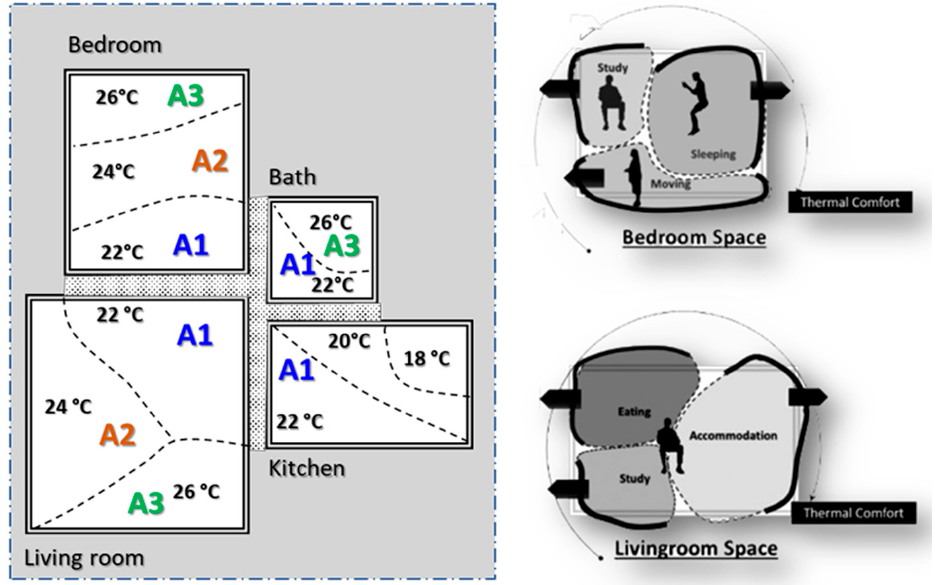
Figure 8. Rooms’ temperature comfort according to human activities and home zones